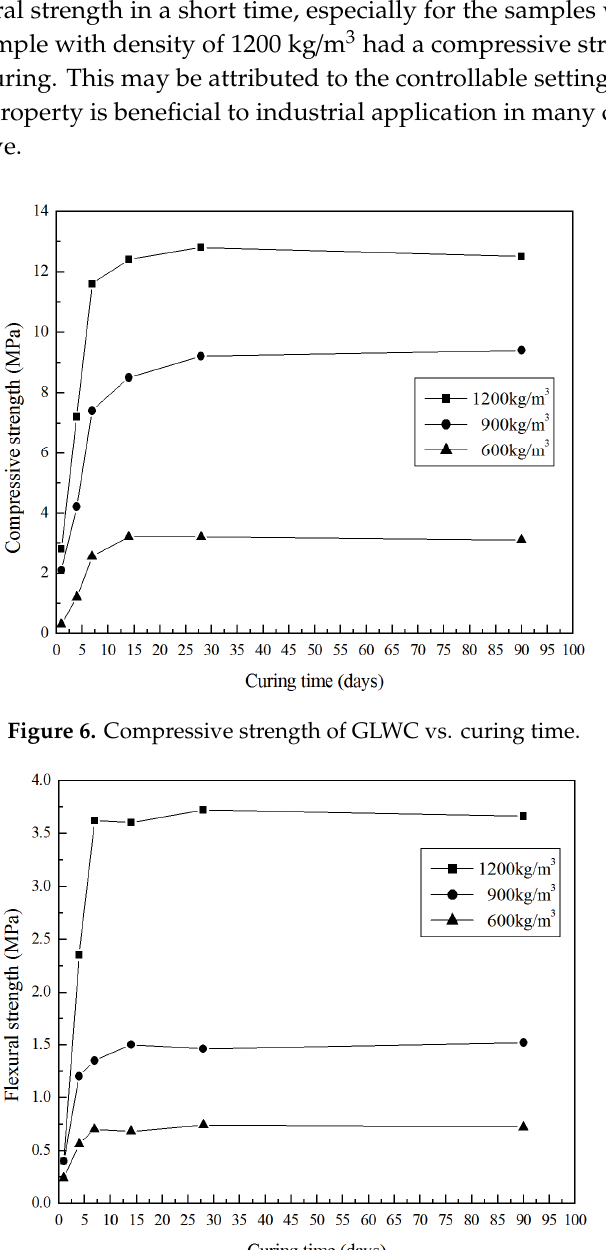
Figure 5. Compressive strength vs. bulk densities of GLWC after curing for 28 days.